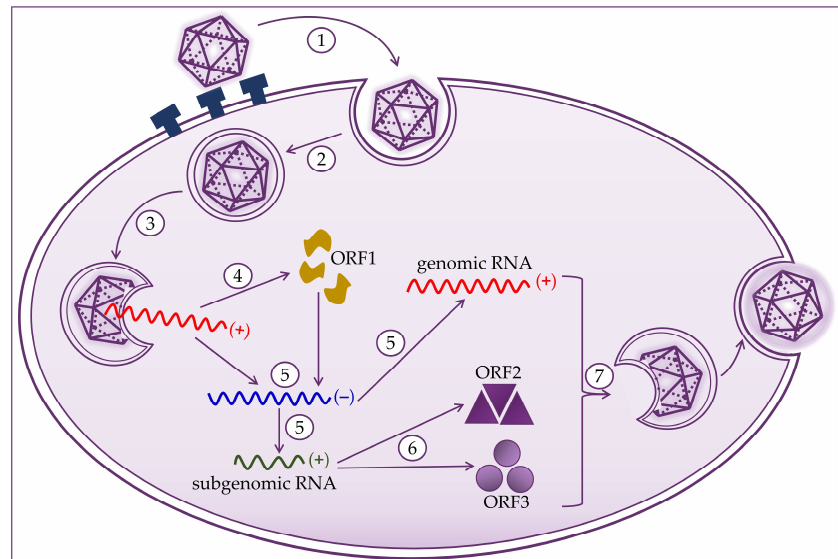
Figure 2. Hepatitis E virus life cycle consists of (1) attachment to heparan sulfate proteoglycans and entry to host cell; (2) clathrin-dependent endocytosis; (3) release of the positive-strand RNA genome into the cytosol; (4) translation to produce the ORF1 proteins; (5) replication via a negative-strand RNA mediator and synthesis of genomic and 2.2 kb subgenomic RNAs; (6) translation of the subgenomic RNA to produce the ORF2 and ORF3 proteins; and (7) packaging, virion assembly, and release of the newly formed